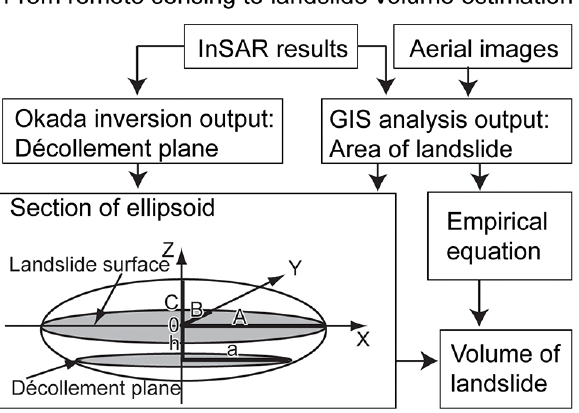
Fig. 3. A flow chart showing data and steps taken to estimate the landslide volume and a sketch of the geometric figure that we used for the volume calculation. “A” is the major axis of an ellipsoid in the X direction, “B” is the major axis of an ellipsoid in the Y direction and “C” is the major axis of an ellipsoid in the Z direction. h is the distance between the plane of the landslide surface and the sliding plane. a is the major axis in the X direction of the sliding plane. The volume is calculated for the area enclosed between the plane of the landslide surface and the sliding